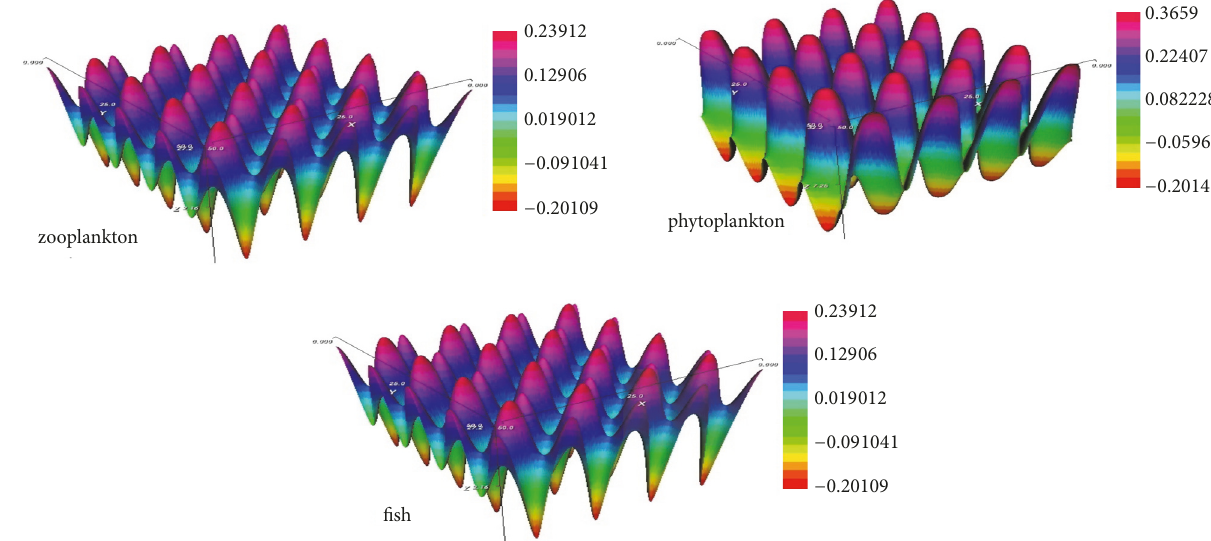
Figure 10: Dynamics behavior for 𝜃 𝑝 = 0.46